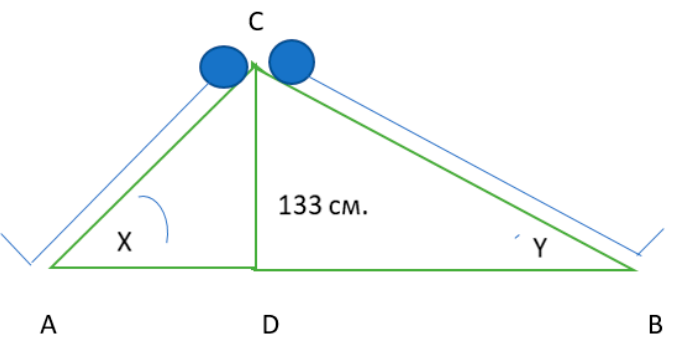
Figure 2. Removal of differences in the height of the test subjects in the Passive orthostatic test (POT), standardized by the height of the hydrostatic column using individual tilt up angles.